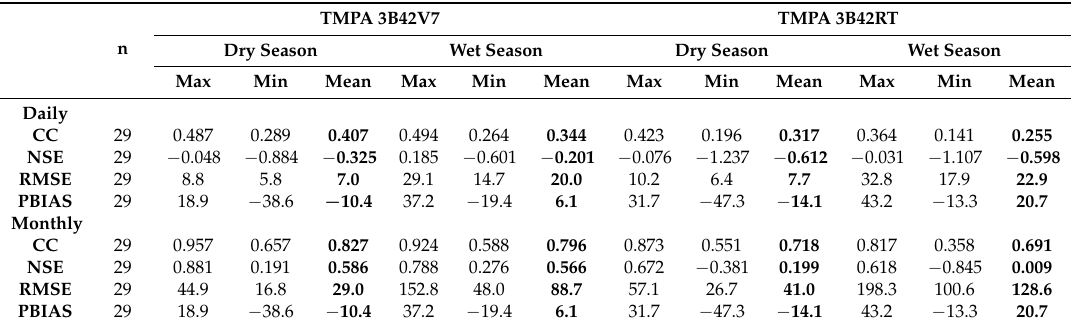
Table 4. Descriptive statistics for daily and monthly observation rain gauge and those of TMPA data during the dry and wet seasons. TMPA 3B42V7 n